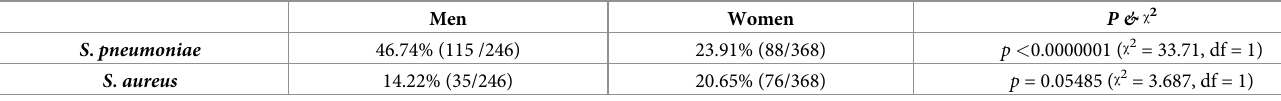
Table 4. Results of prevalence of pathogenic bacteria in Dielmo and Ndiop by